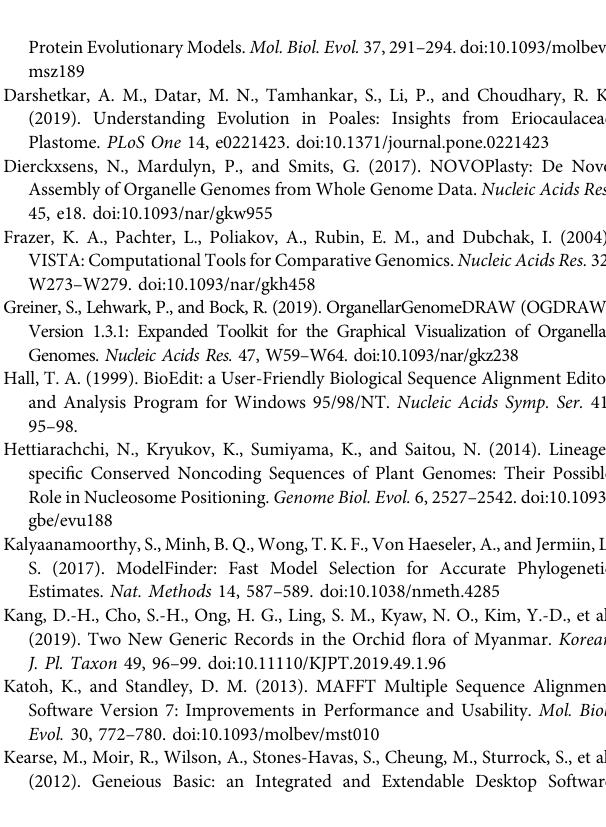
correspond to codons listed underneath the columns. Rows in each column diagram represent the number of groups. Supplementary Figure S2 | Radar chart showing the ENC values of the coding genes in the cp genomes of Thunia alba (L01 and L02) and Thuniopsis cleistogama (L03, L04 and L05). Supplementary Figure S3 | ENC plot showing the relationship between ENC values and GC3s for the cp genomes of Thunia alba (L01 and L02) and Thuniopsis cleistogama (L03, L04 and L05). The continuous curve represents the expected codon usage if GC compositional constraints alone account for codon usage bias. Supplementary Table S1 | Codon frequencies and relative synonymous codon usage (RSCU) values of the cp genomes of Thuniopsis and Thunia . SupplementaryTableS2| TheENCvaluesofthecodinggenesinthecpgenomes of Thunia alba (L01 and L02) and Thuniopsis cleistogama (L03, L04 and L05). Supplementary Table S3 | The GC contents of three positions of codons (GC1, GC2 and GC3) in the cp genomes of Thunia alba (L01 and L02) and Thuniopsis cleistogama (L03, L04 and L05. Supplementary Table S4 | Simple sequence repeats (SSRs) detected in the cp genomes from three Thuniopsis cleistogama individuals and two Thunia alba individuals. Supplementary Table S5 | The statistics of SNPs and InDels identi fi ed for each plastome alignments between Thuniopsis and Thunia species presented here